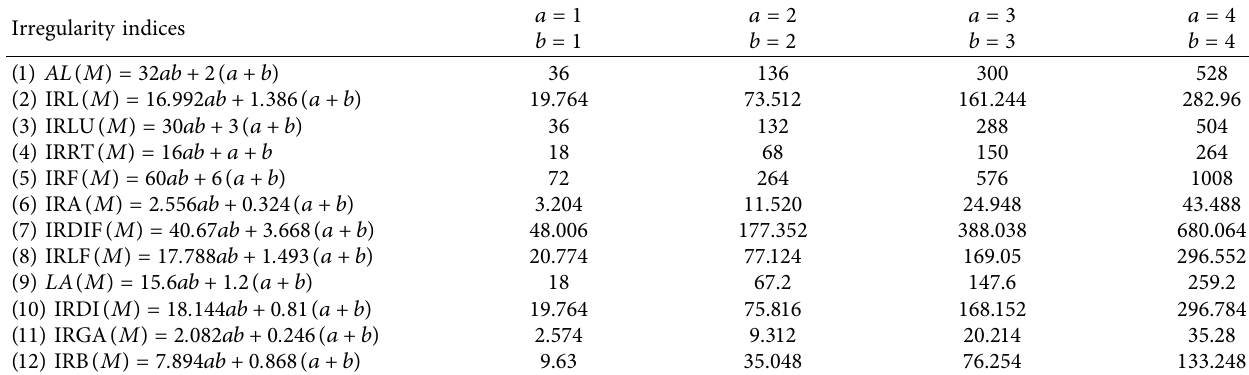
H N HCl [ a, b ] . 20 19 3